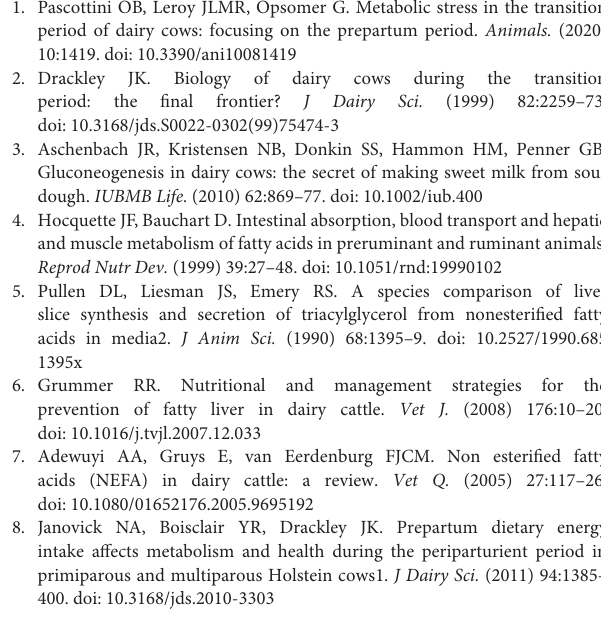
Supplementary File 1 | Complete dataset with annotation and statistical results. Supplementary File 2 | Comparison between RTqPCR and RNAseq for selected transcripts. Supplementary Figure S1 | Principal component analysis of the RNAseq. Supplementary Figure S2 | Enriched GO terms within the cohort of genes significantly upregulated (FDR-adjusted p -value < 0.2) by treatment with the PPAR α agonist. Supplementary Figure S3 | Enriched GO terms within the cohort of genes significantly downregulated (FDR-adjusted p -value < 0.2) by treatment with the PPAR α agonist. Supplementary Figure S4 | Enriched GO terms within the cohort of genes significantly upregulated (FDR-adjusted p -value < 0.2) by treatment with the PPAR δ agonist. Supplementary Figure S5 | Enriched GO terms within the cohort of genes significantly downregulated (FDR-adjusted p -value < 0.2) by treatment with the PPAR δ agonist. Supplementary Figure S6 | Enriched GO terms within the cohort of genes significantly upregulated (FDR-adjusted p -value < 0.2) by treatment with the PPAR γ agonist. Supplementary Figure S7 | Enriched GO terms within the cohort of genes significantly downregulated (FDR-adjusted p -value < 0.2) by treatment with the PPAR γ agonist. Supplementary Table S1 | Accession number, gene symbol, sequence, and amplicon size of quantified genes, and internal control genes. If reference is lacking, primers were designed for this